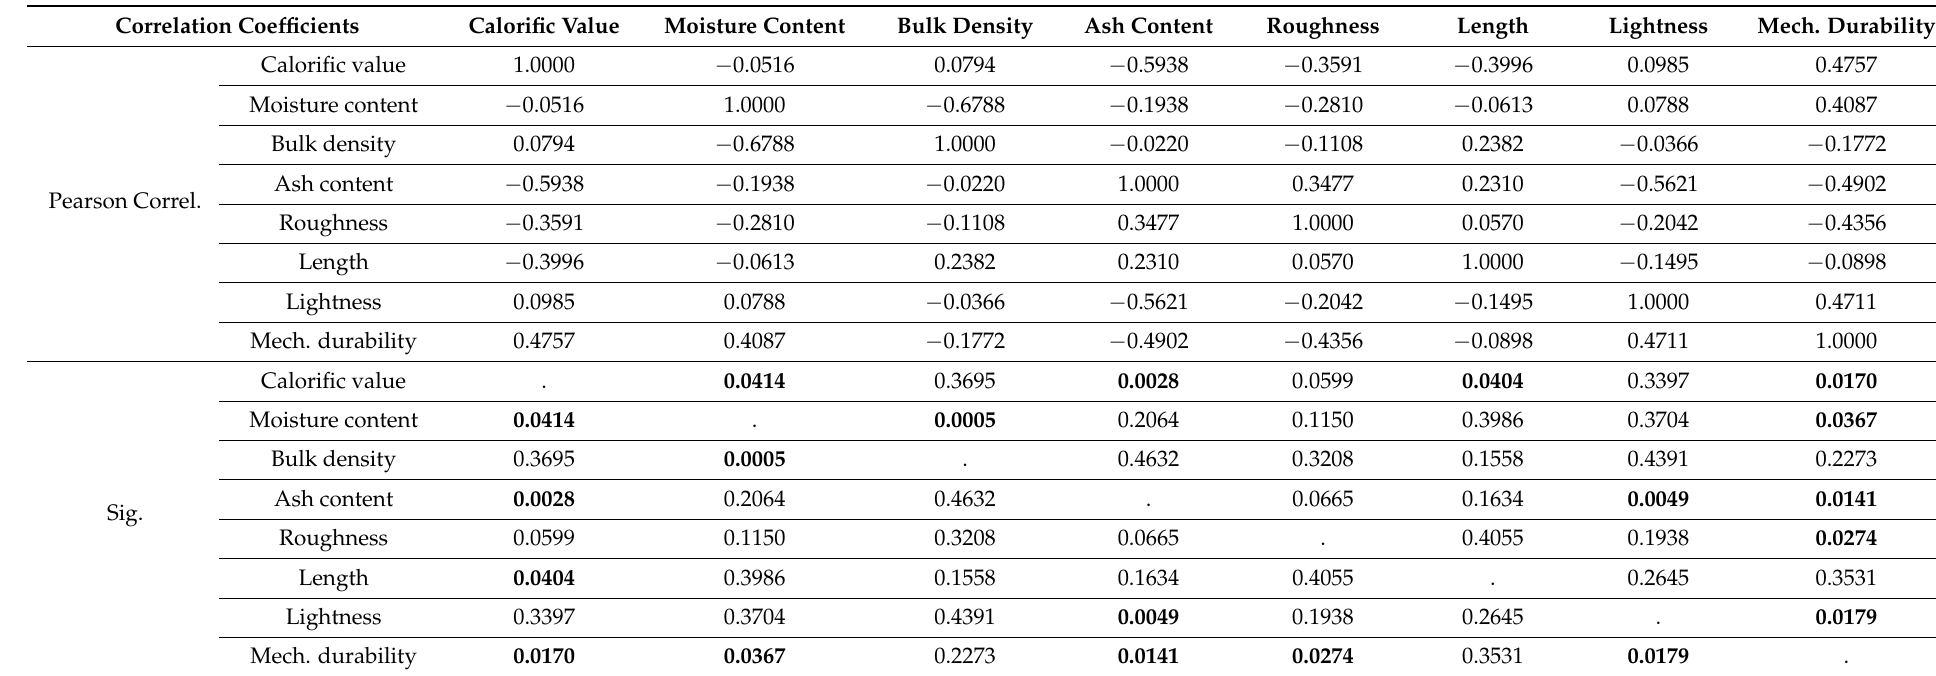
Table 2. Degree (Pearson correlation coefficients) and significance of correlations between the characteristics of the 20 pellet brands. In the second half of the table, the significant correlation values (<0.05) are depicted in